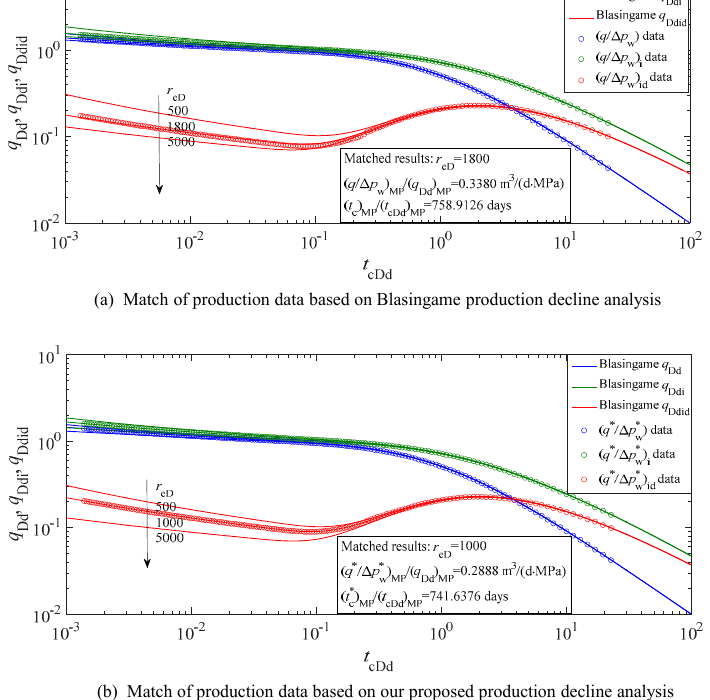
Figure 26. Match of production data for Case 3.